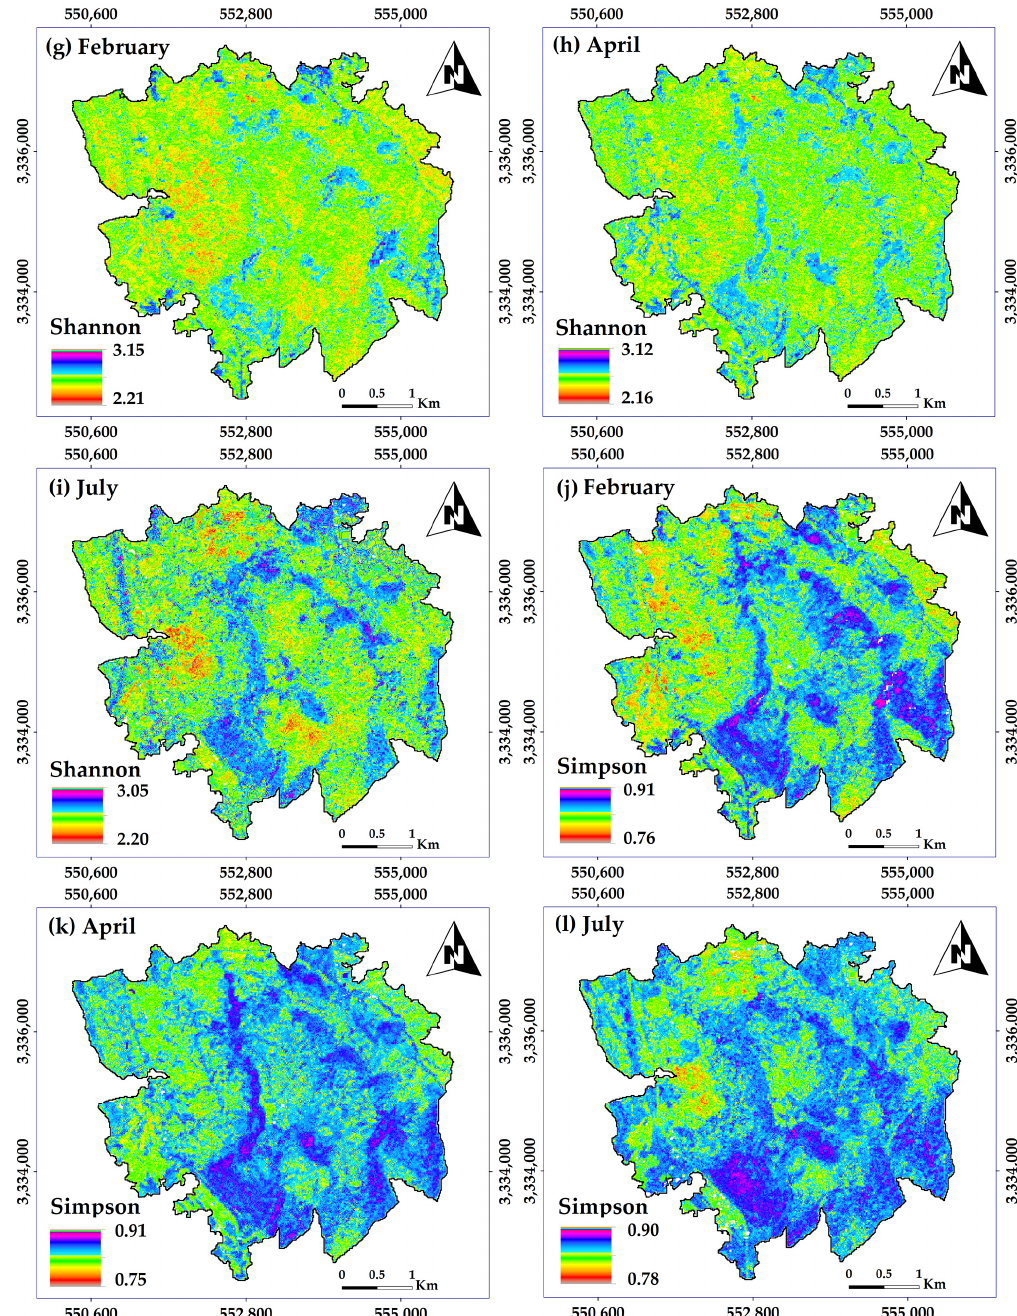
Figure 3. Spatial distribution of richness for February ( a ), April ( b ), and July ( c ); vegetation cover for February ( d ), April ( e ), and July ( f ); Shannon for February ( g ), April ( h ), and July ( i ); and Simpson for February ( j ), April ( k ), and July ( l